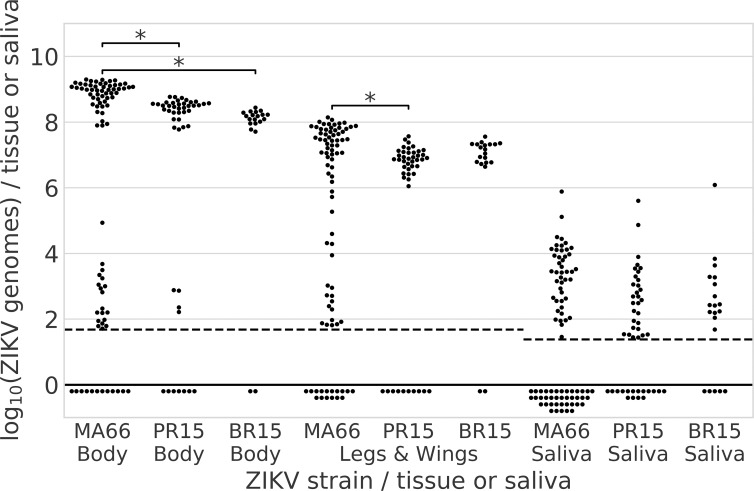
Infecting (bodies), disseminating (legs+wings) and transmitted (saliva) ZIKV RNA levels 14 or 15 days after Ae. aegypti orally ingested one of three Asian lineage ZIKV strains.Each dot represents the mean log10 ZIKV genome copies per tissue or saliva sample from an individual Ae. aegypti. Ae. aegypti from Los Angeles, California, USA, were fed on viremic mice infected with ZIKV from Malaysia 1966 (MA66), Puerto Rico 2015 (PR15) or Brazil 2015 (BR15). Mosquitoes exposed to BR15 were assayed 15 dpf, MA66 and PR15 cohorts were assayed 14 dpf. Each dot represents the mean of two or more RT-qPCR technical replicates. The dashed lines represent the limits of detection (LOD). Dots below dashed line represent tested samples with an undetectable Ct or a Ct value of >38. The LOD for saliva was lower than for tissues because RNA was extracted from a higher proportion of the saliva sample volume. Asterisks show significant differences in means across groups of the same tissue type, P<0.01, ANOVA, Tukey post-hoc test. No asterisk indicates no significant difference across groups.